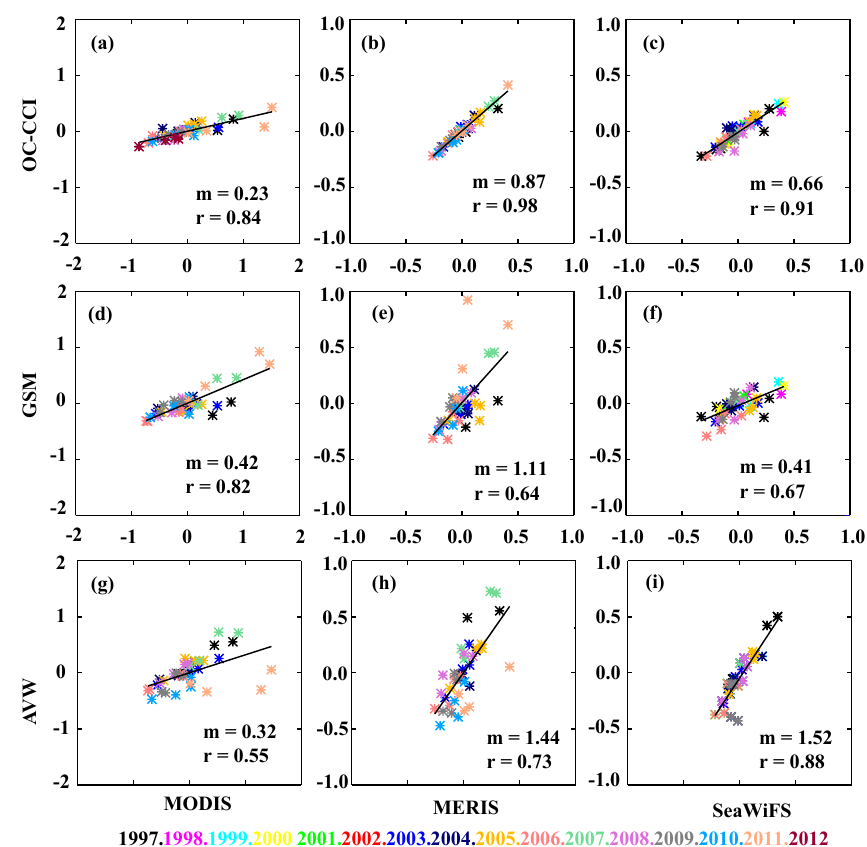
Figure 4. (a, b, c) Scatter plot of interannual anomalies in NAS-averaged monthly winter (DJFM) SChl (mgm − 3 ) in the OC-CCI product against MODIS, MERIS, and SeaWiFS products. (d, e, f) Idem for GSM product. (g, h, i) Idem for AVW product. All the correlations ( r ) and regression coefficients ( m ) indicated in each panel are significantly different from zero at the 90% confidence